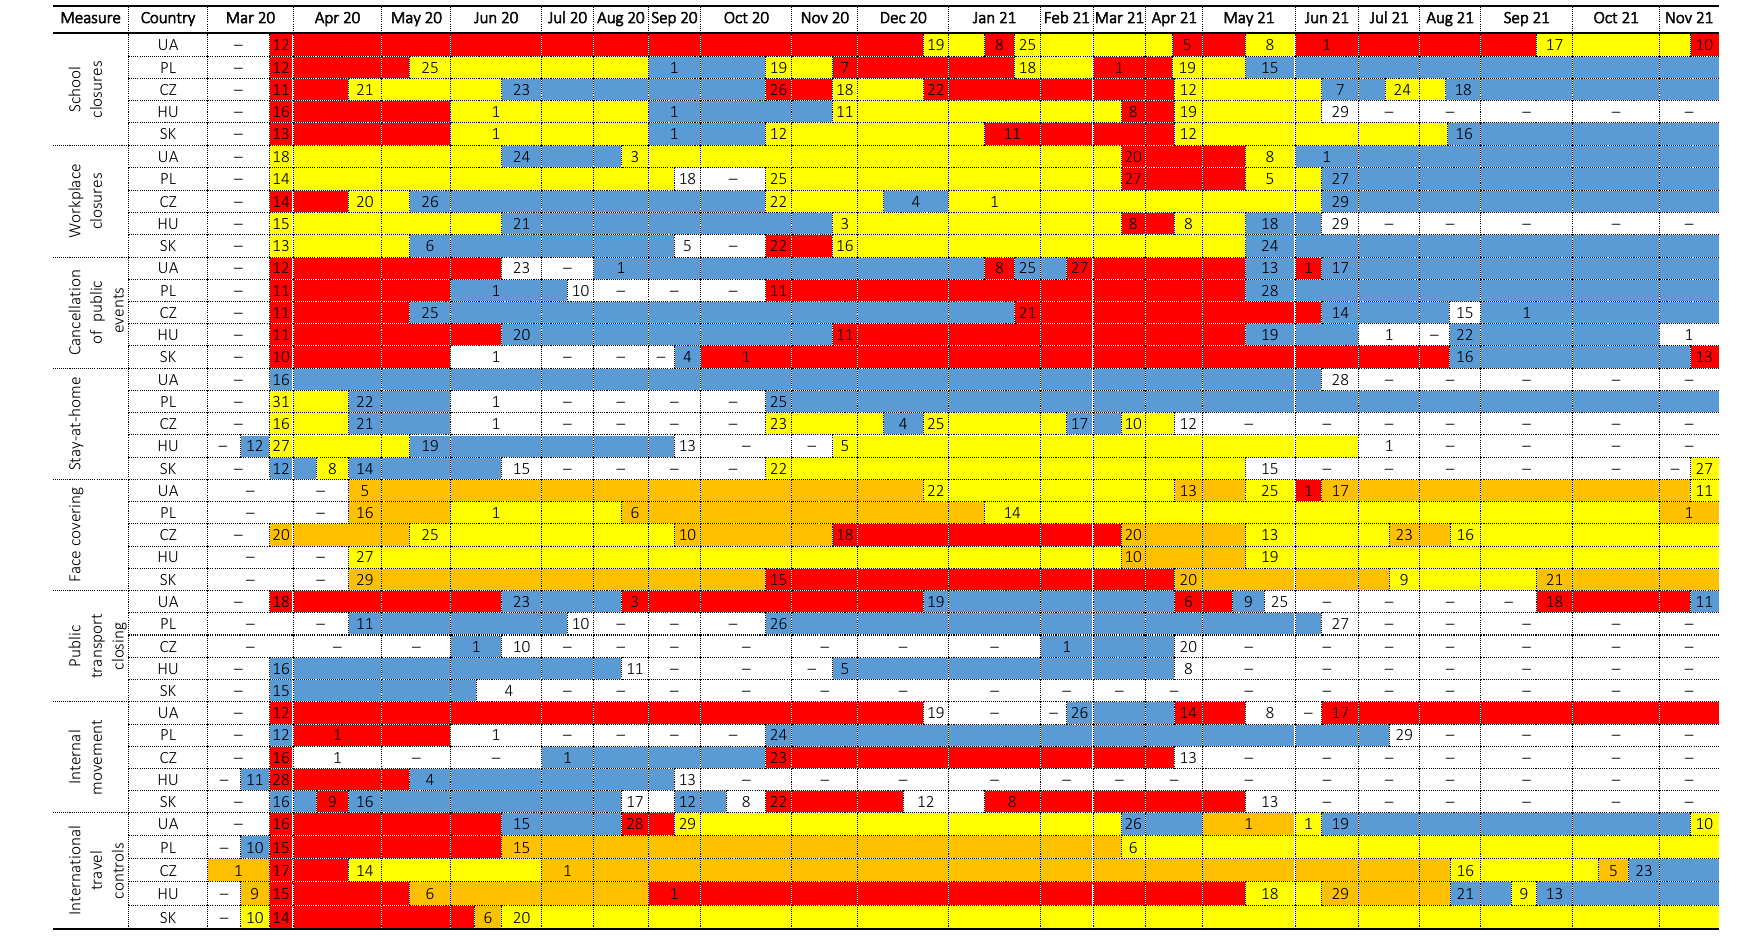
Source: Our World in Data